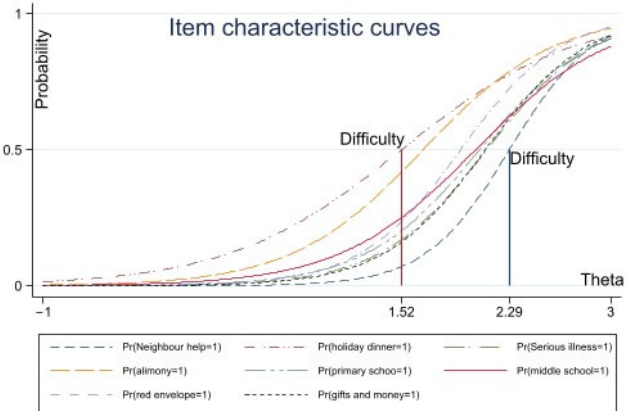
Figure 2. ICC of ‘higher difficult’ items.